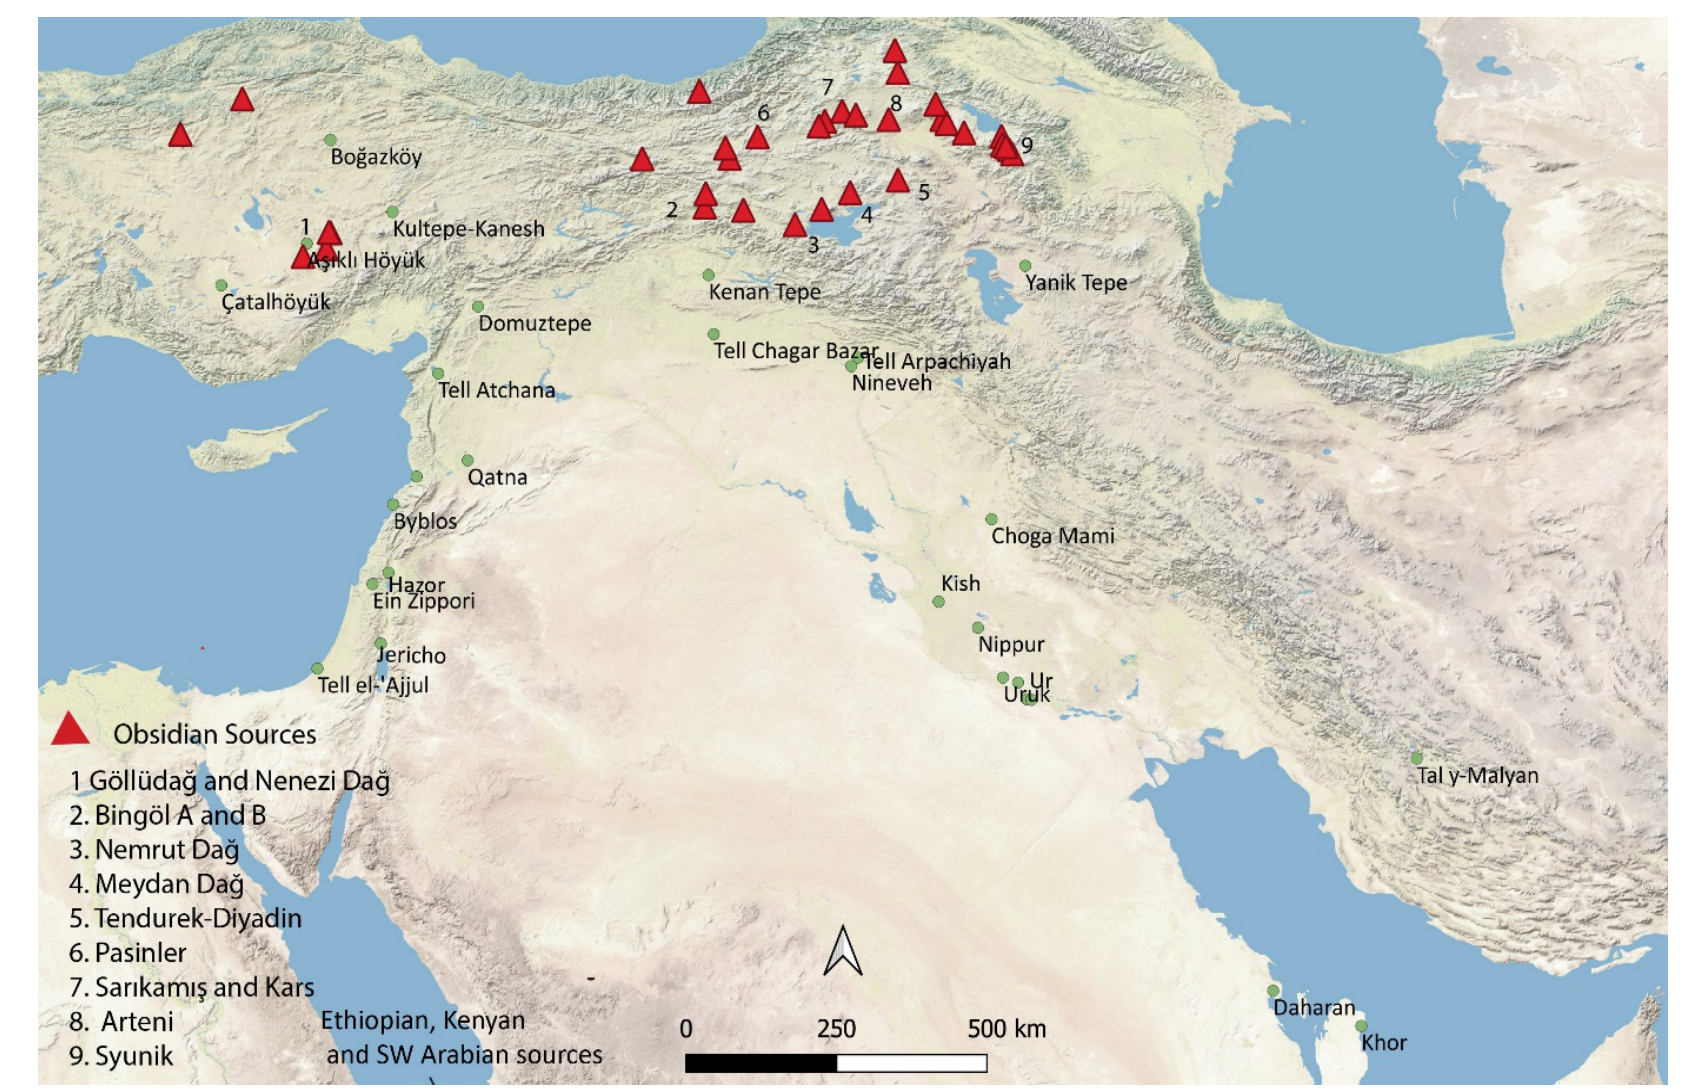
Figure 11. Map showing the location of sites from which the origin of obsidian objects has been